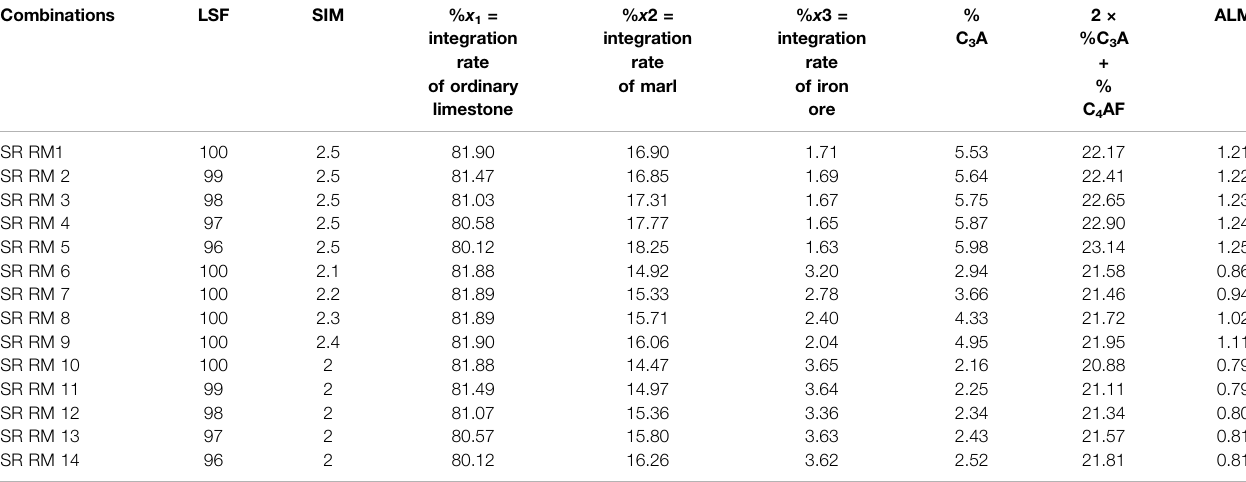
TABLE 6 | SR Portland raw meal combinations by using three raw materials used in ordinary cement production in the SCB factory. Combinations LSF SIM % x 1 =